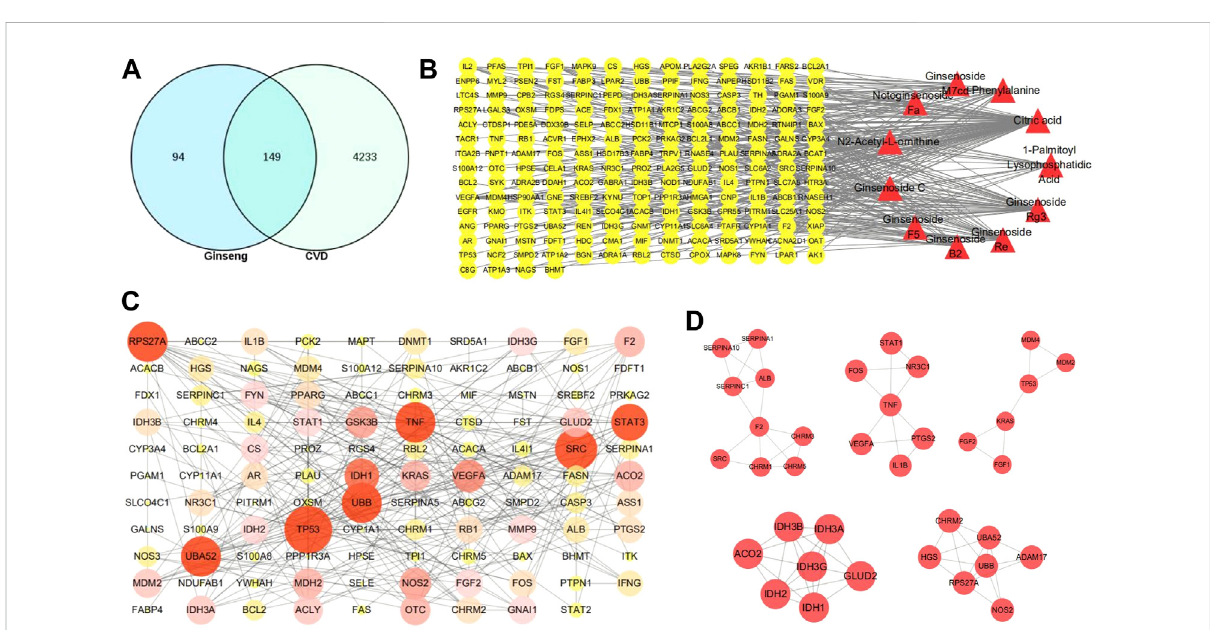
FIGURE 2 Target screening and network construction. (A) The venn diagram of the targets of gingseng and cardiovascular diseases (CVDs). (B) “ Components-targets ” network. The yellow circles represent the common targets of gingseng and CVD; the red triangle represents the differential components between MCG and GG. (C) Protein – protein interaction (PPI) network. The higher the degree value, the more red the color and the larger the shape. (D) Five closely connected submodules in the network. The 5-nucleon module is the interaction between tumor protein receptors, the 3-nucleon and 1-nucleon module is the interaction between cardiovascular pathway-related proteins, and the 2-nucleon module is the interaction between in fl ammation-related